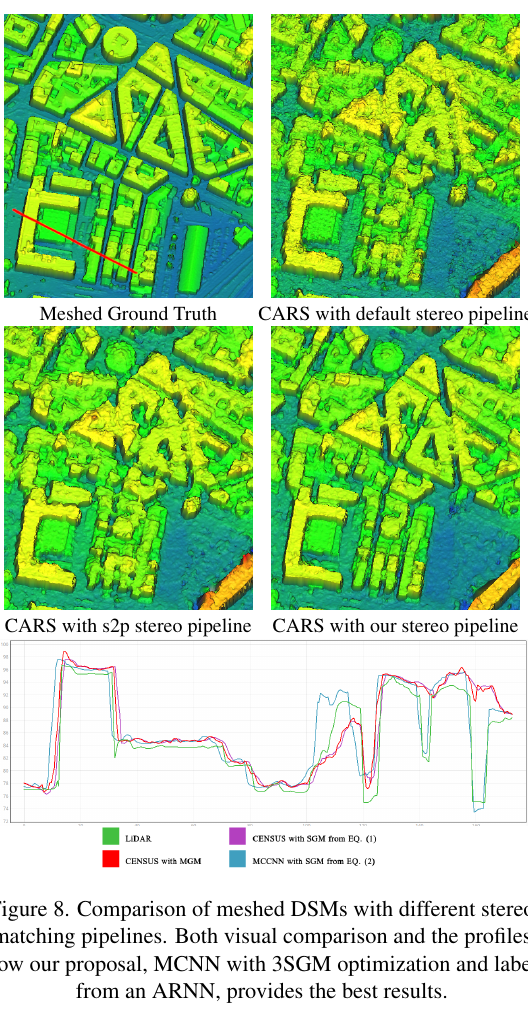
Figure 8. Comparison of meshed DSMs with different stereo matching pipelines. Both visual comparison and the profiles show our proposal, MCNN with 3SGM optimization and labels from an ARNN, provides the best results.